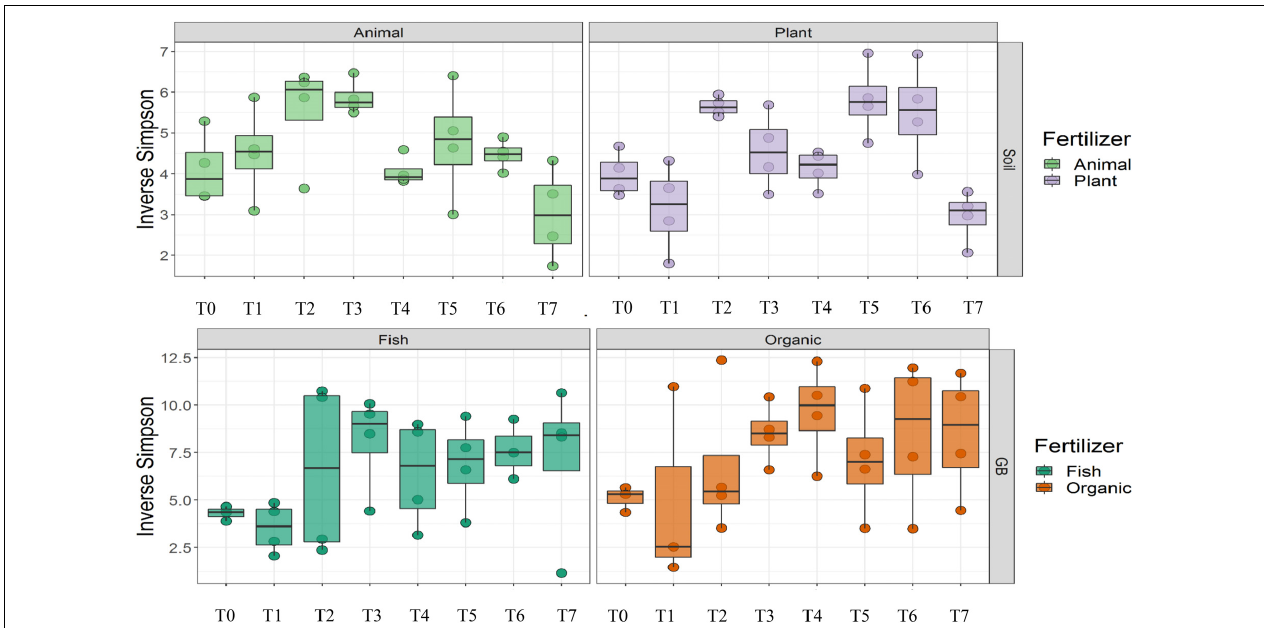
FIGURE 4 | Culture system impacted bacterial community characteristics and showed opposite trends. Alpha diversity was lower and oscillated over time in soil (upper panel) , while it steadily increased in soilless systems and remained high at the end of the experiment (lower panel) . Samples for microbial community analysis were taken at 8 different timepoints, i.e., 55 DAS (T0), 68 DAS (T1), 83 DAS (T2), 113 DAS (T3), 146 DAS (T4), 172 DAS (T5), 221 DAS (T6), and 321 DAS (T7).